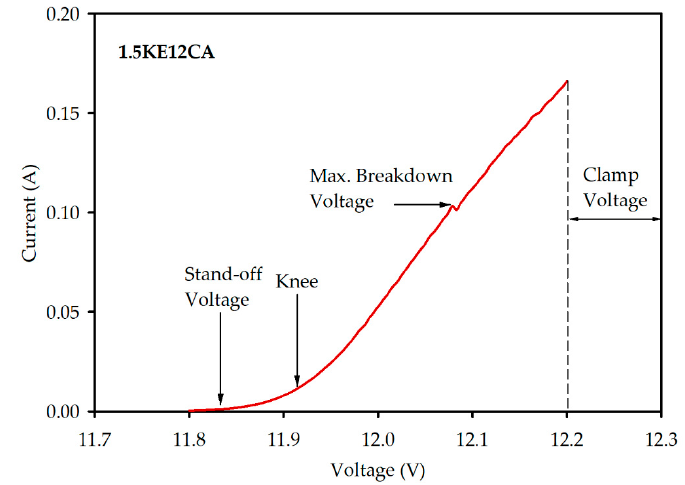
Figure 4. Forward bias characteristic curve for a 1.5KE12CA Zener diode.